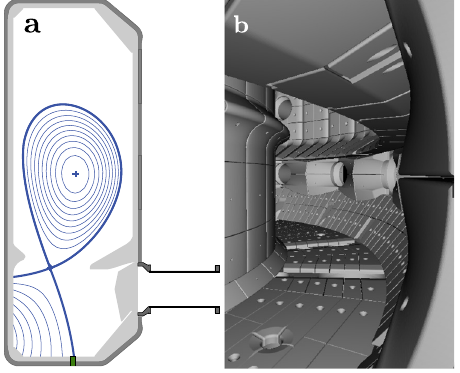
Fig. 2 The TCV tokamak and MANTIS view. a Cross-section of TCV showing the plasma magnetic fl ux surfaces (blue) for diverted discharge #65349, the vacuum vessel including baf fl es (light gray), the MANTIS view port, and the location of the fueling gas valve (green). b Rendering of the MANTIS view into the TCV vacuum vessel 52 . The fi eld-of-view is restricted by the TCV fl oor (bottom) and outer baf fl e structure (top).